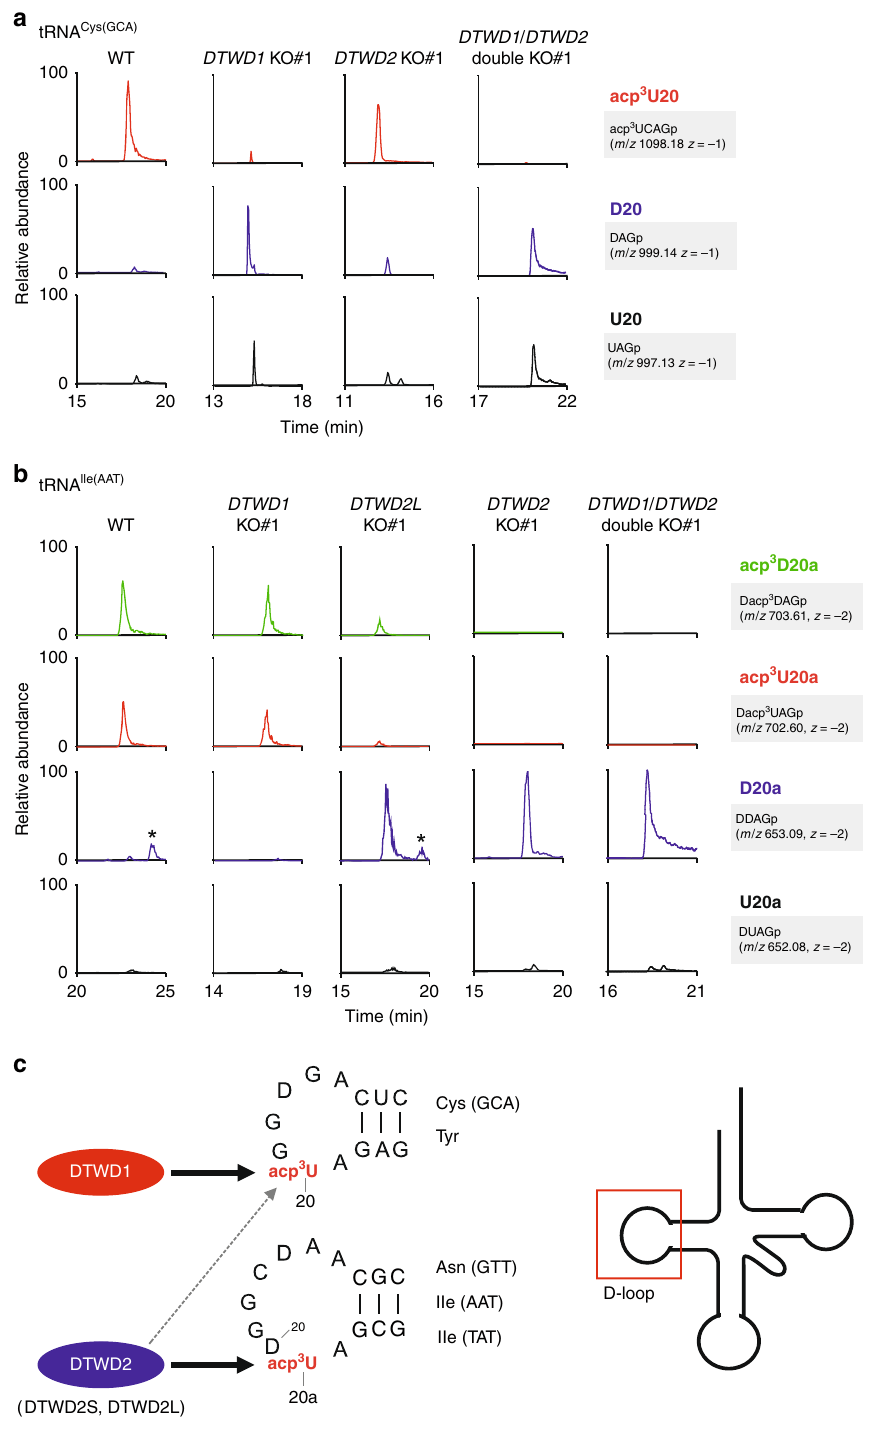
Fig. 4 Human DTWD1 and DTWD2 are responsible for acp 3 U formation. a Mass spectrometric analyses of acp 3 U20 in tRNA Cys(GCA) isolated from WT (left), DTWD1 KO (left middle), DTWD2 KO (right middle), and DTWD1 / DTWD2 double-KO (right) strains. XICs show corresponding negative ions of the RNase T 1 -digested fragments as indicated on the right-hand side of each chromatogram. Mass spectra of acp 3 D- or D-containing fragments overlap with the isotopic peaks of acp 3 U- or U-containing fragments. The peak intensities of these fragments are normalized in consideration of those isotopes. Asterisk indicates nonspeci fi c peaks with the same m/z value. b Mass spectrometric analyses of acp 3 U20a in tRNA Ile(AAT) isolated from WT (left), DTWD1 KO (left middle), DTWD2L KO (middle), DTWD2 KO (right middle), and DTWD1 / DTWD2 double-KO (right) strains. c Substrate speci fi city of human DTWD1 and DTWD2. DTWD1 is responsible for acp 3 U20 formation in tRNAs for Cys(GCA) and Tyr, whereas DTWD2 is responsible for acp 3 U20a formation in tRNAs for Asn(GTT), Ile(AAT), and Ile(TAT). DTWD2 also has a weak activity to form acp 3 U20. The sequence of tRNA Cys and tRNA Asn are